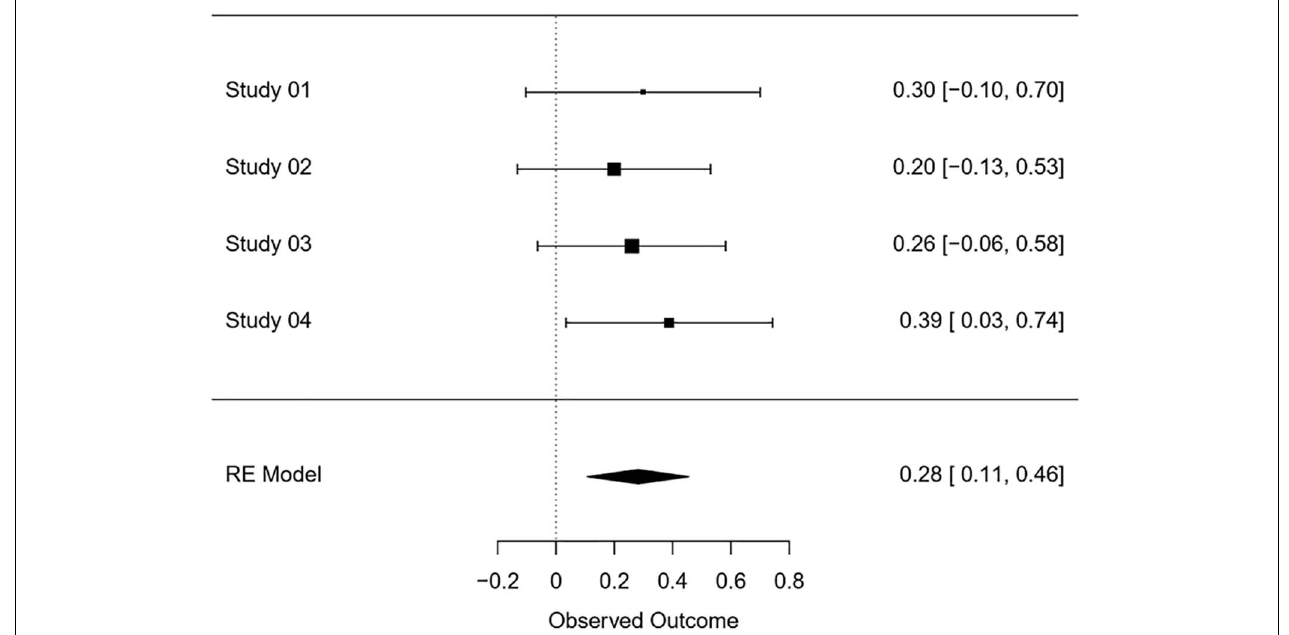
FIGURE 4 | Meta-analysis of the four studies. Forest plot, random effects model were calculated for the number of correct answers on the task as dependent variable, including condition as independent